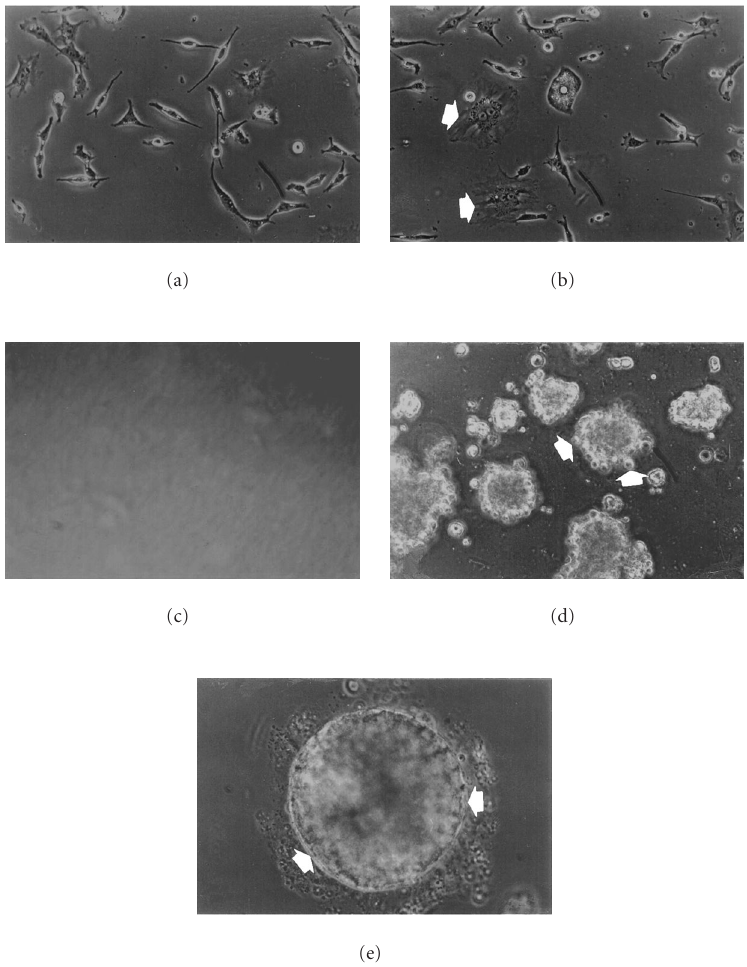
Figure 1. (a) Dedi ff erentiated chondrocytes with a fibroblast-like phenotype in primary culture on plastic, OM 50 X. (b) Subcul- tured chondrocytes on plastic show the appearance of some polymorphic cells (arrow), OM 50 X. (c) Immunofluorescence of type II collagen shows a negligible labelling in confluent monolayers, even in primary cell cultures, OM 25 X. (d) Dedi ff erentiated chondro- cytes cultured in suspension for one week form aggregates of round cells; note the round shape of peripheral cells (arrow), OM 50 X. (e) Aggregates cultured in suspension for more than one week show peripheral perichondrium-like cell flattening (arrow), OM 50